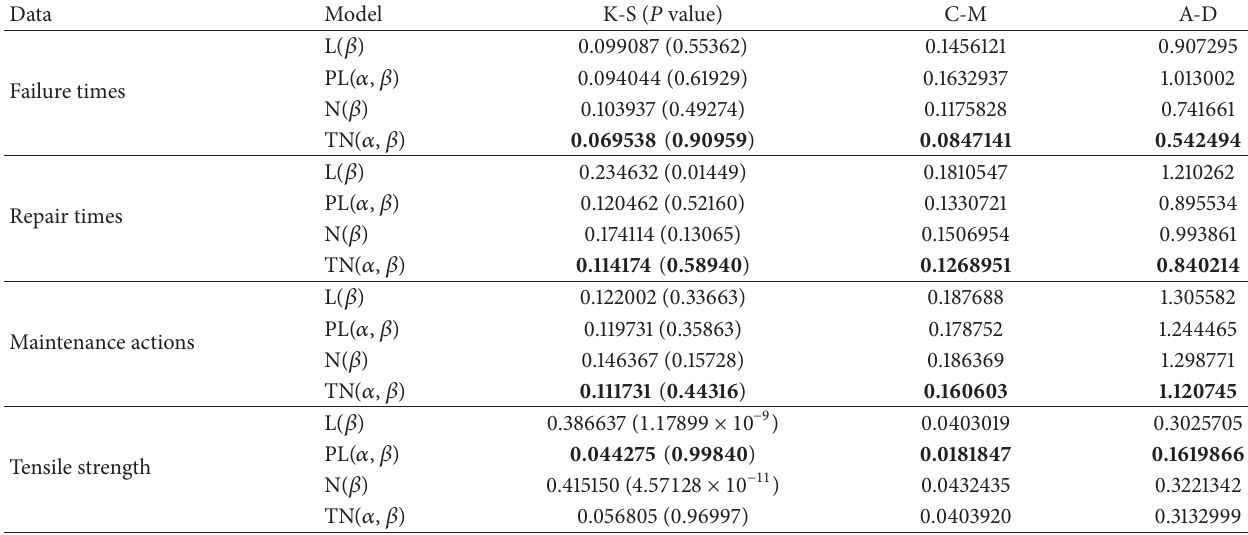
Figure 10: The TTT-transform, hazard, pdf, and cdf of the maintenance actions data. Table 2: Statistics K-S ( 𝑃 value), C-M, and A-D for the four data